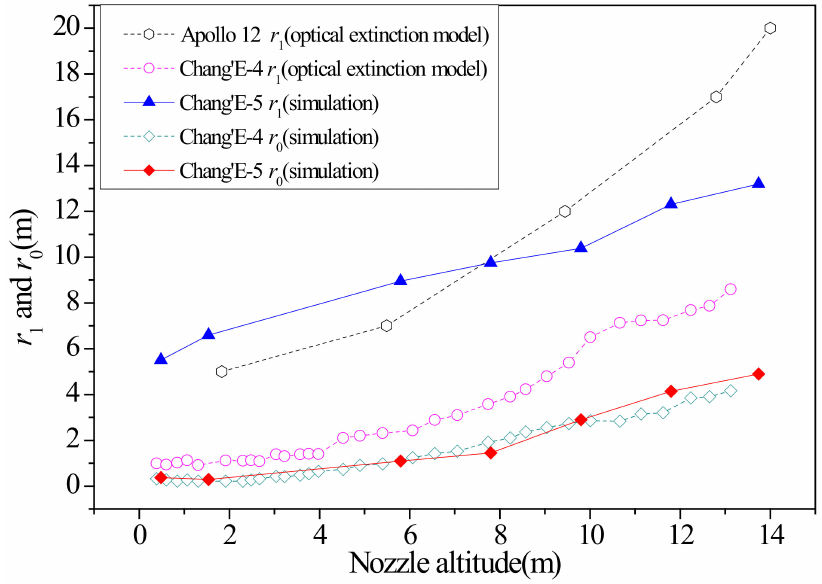
Figure 6. The r 1 and r 0 of the Chang’E-4 and Chang’E-5 missions and the Apollo missions.